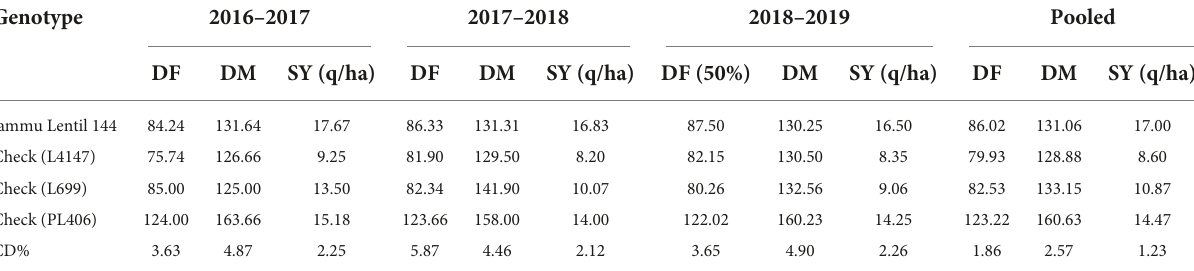
TABLE 4 Performance of selected derivative Jammu Lentil 144 along with checks during winter seasons of 2016–2017, 2017–2018, and 2018–2019.